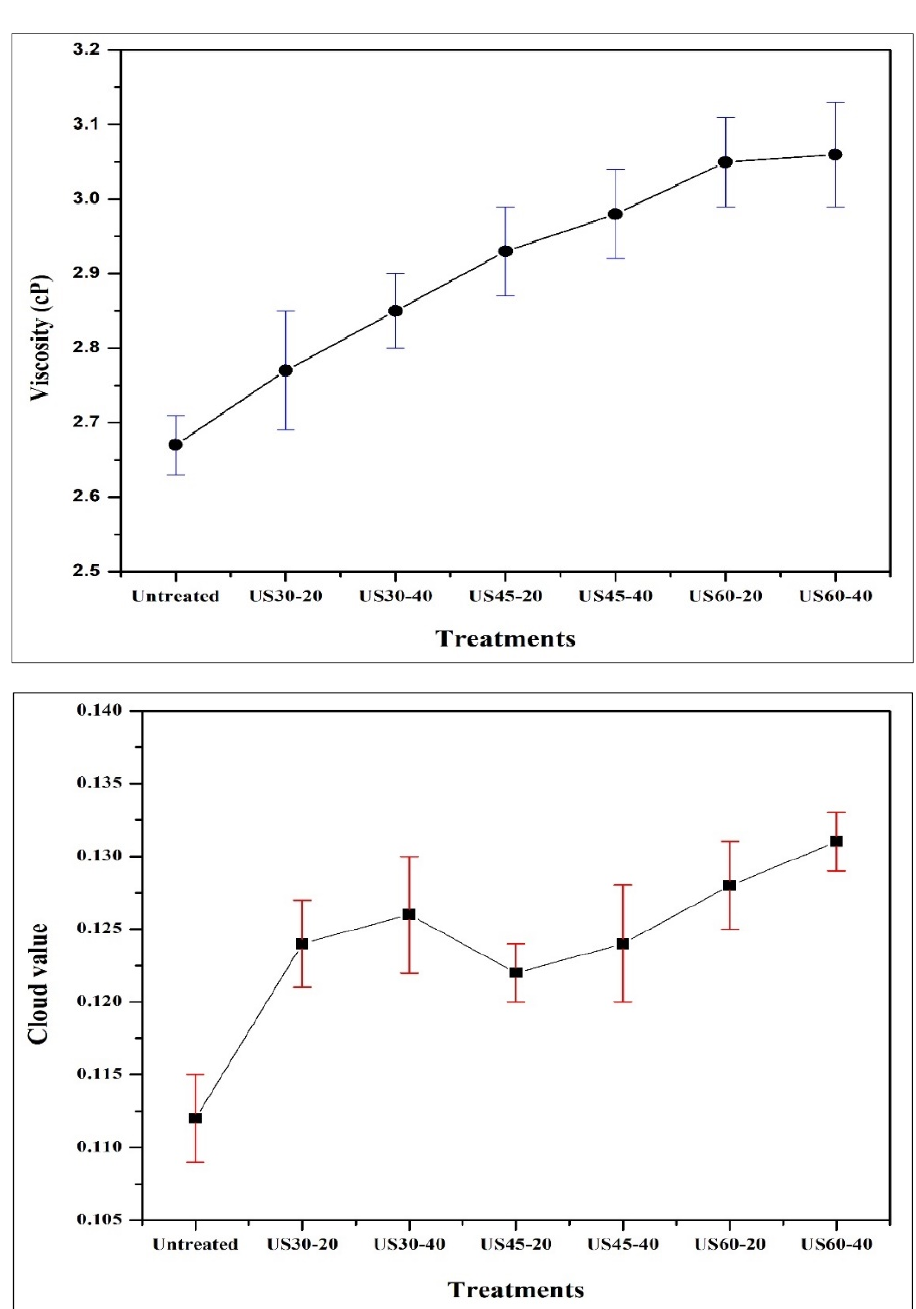
Figure 2. Effect of TU treatment on the viscosity and cloud value of wheat plantlets juice. Results are expressed as mean and standard deviation (SD) (n = 3). Table 8. Impact of TU treatment on color properties.